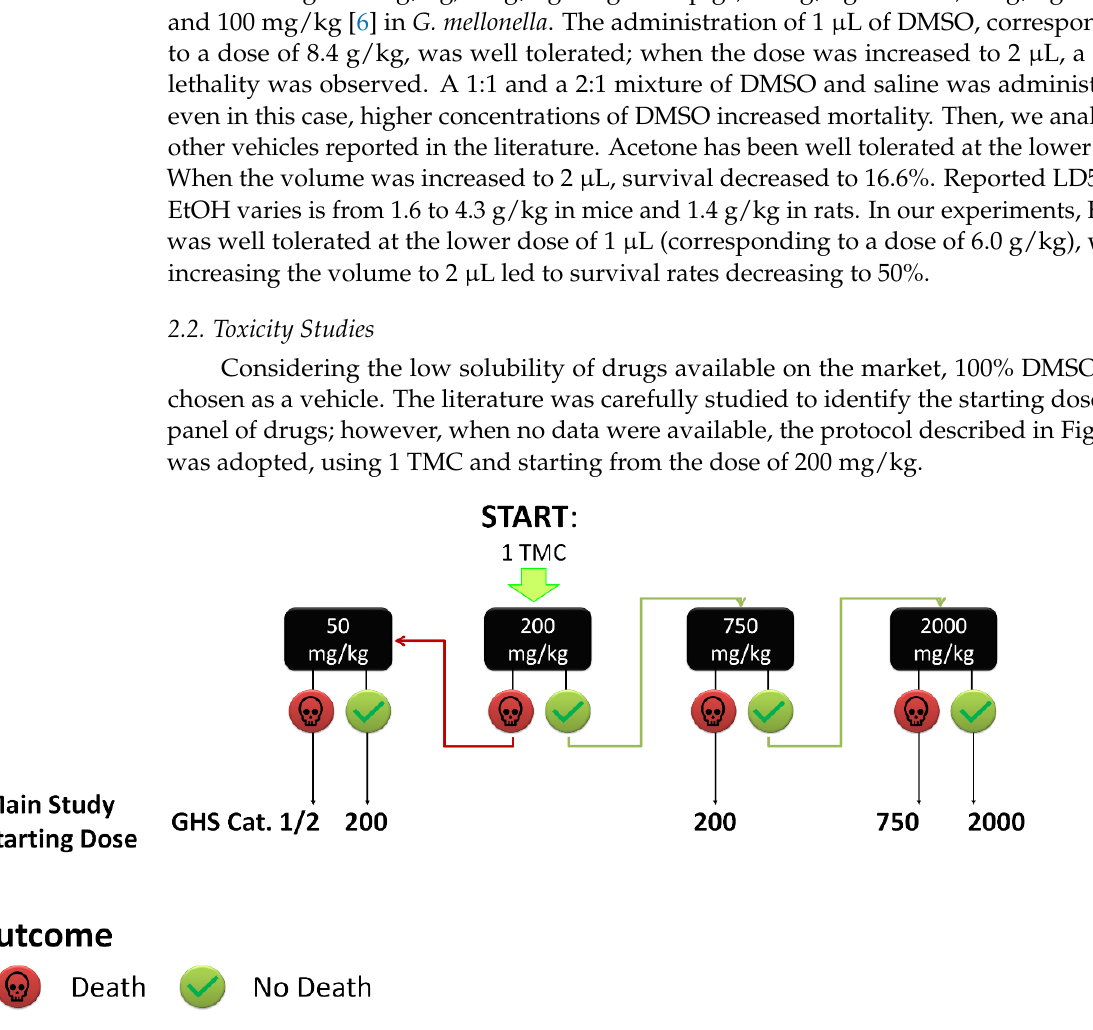
Figure 1. Flowchart for the starting dose selection. When no data were available, we administered a single dose of 200 mg/ kg to 1 TMC, increasing or decreasing the dose on the basis of obtained results. GHS cat.: Globally Harmonized System